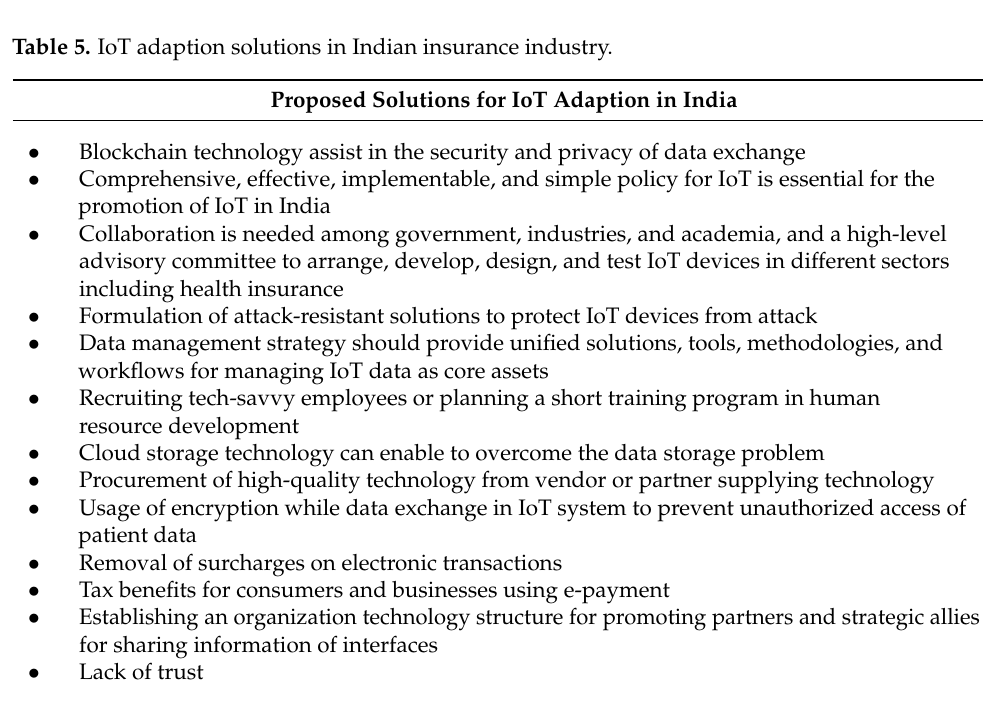
Table 5. IoT adaption solutions in Indian insurance